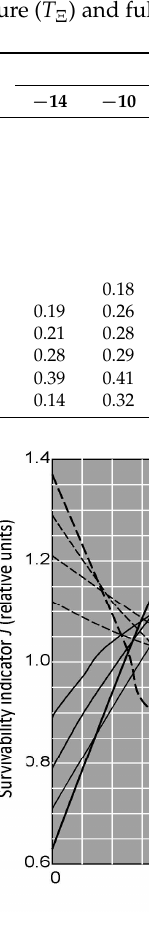
Figure 9. Survivability indicator depending on the GDP distribution by agriculture (solid lines) and industry (dashed lines). Numbers located on the right of the curves show the time periods for the